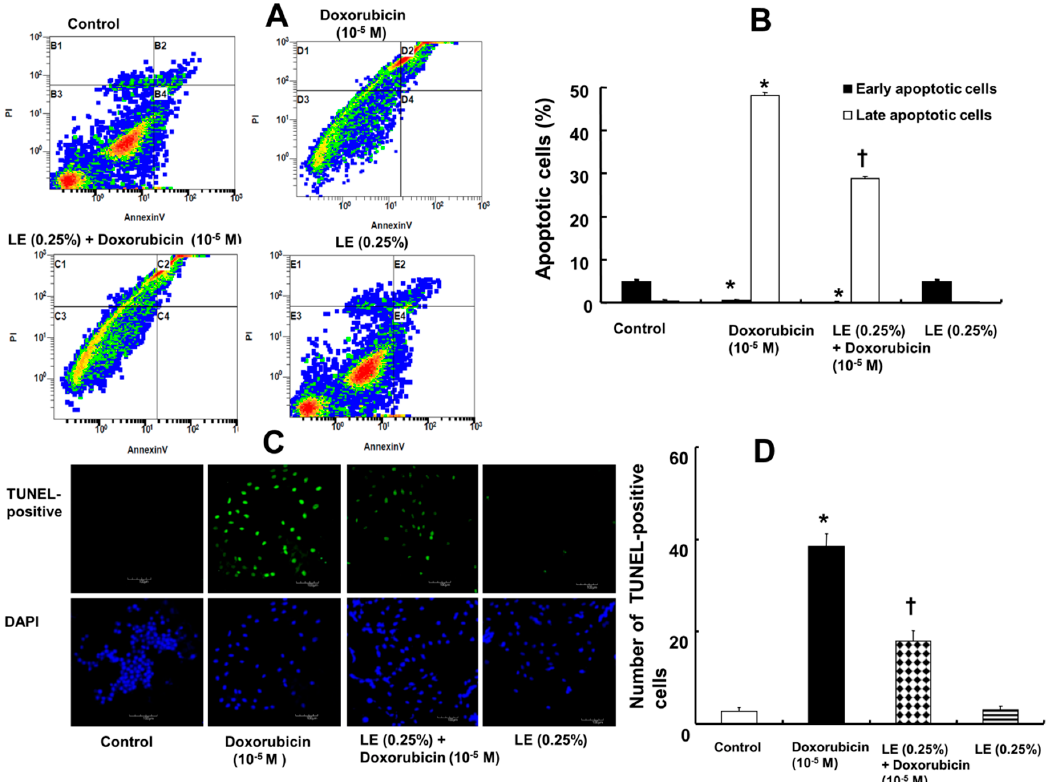
Figure 2. Effects of Intralipid ® (lipid emulsion, LE) on the doxorubicin-induced apoptosis of H9c2 rat cardiomyoblasts. The cells were pretreated with doxorubicin (10 − 5 M) alone for 6 h, LE (0.25%) for 1 h followed by doxorubicin (10 − 5 M) for 6 h, or LE (0.25%) alone for 7 h. ( A ) Annexin-V-FITC/propidium iodide staining followed by flow cytometric analysis. ( B ) Plot (N = 3) showing both early- and late-stage apoptosis after treatment. ( C ) TUNEL assay showing DNA damage after treatment as detected by immunofluorescence. Nuclei were stained with 4 ′ ,6-diamidino-2-phenylindole (DAPI) and are shown in blue. TUNEL-positive cells appear green. Scale bar: 100 μ m. ( D ) Representative plot (N = 3) showing TUNEL-positive cells in different treatment groups. ( B , D ): Data are shown as the mean ± SD. N indicates the number of independent experiments. * p < 0.001 versus control. † p < 0.001 versus doxorubicin alone.